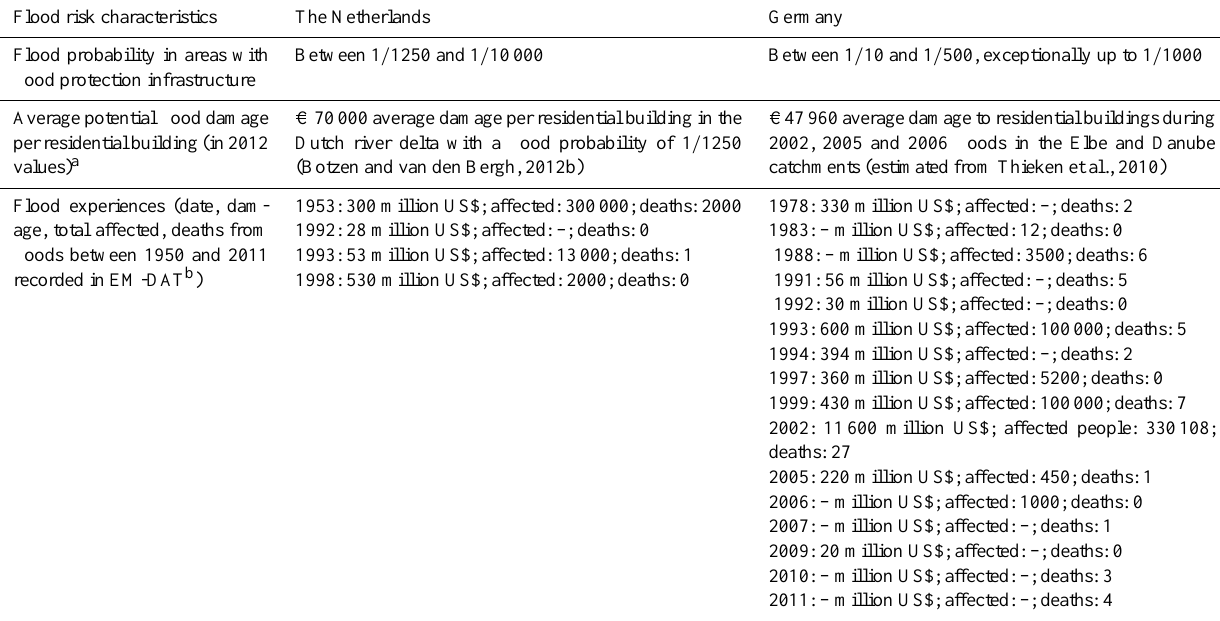
Table 1. Characteristics of flood risks where inundation up to the dyke hinterland and possible damage is involved in the Netherlands and Germany, including flood experiences between 1950 and